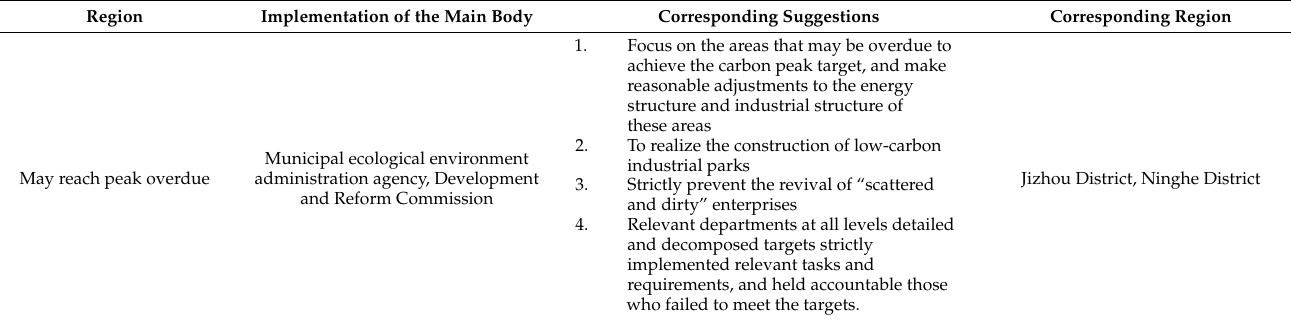
Table 6. Recommendations for areas that may be overdue for carbon